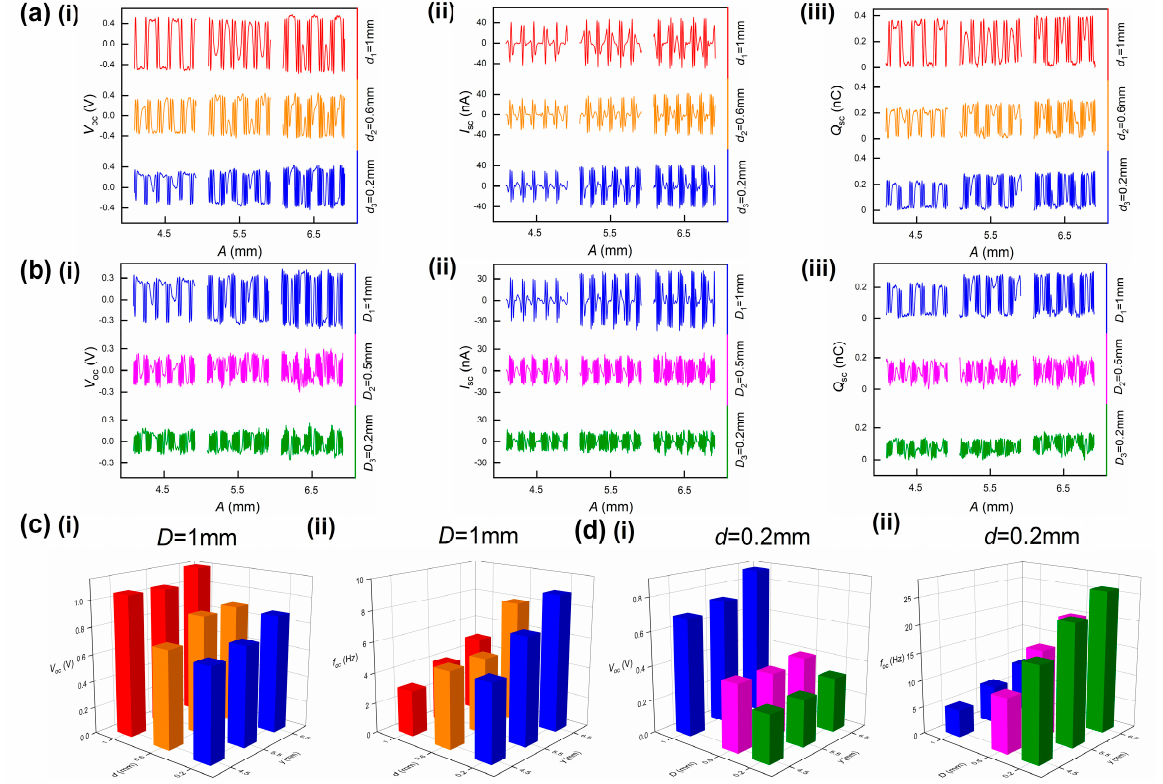
Figure 4. Optimization of electrodes’ width and spacing. ( a ) VI − TENG’s performance at different spacing: (i) open circuit voltage, (ii) short circuit current and (iii) amount of charge transferred; ( b ) VI − TENG’s performance at different widths: (i) open circuit voltage, (ii) short circuit current and (iii) amount of charge transferred; ( c ) characteristics of open circuit voltage at different spacing: (i) amplitude and (ii) frequency; ( d ) characteristics of open circuit voltage at different widths: (i) amplitude and (ii) frequency.